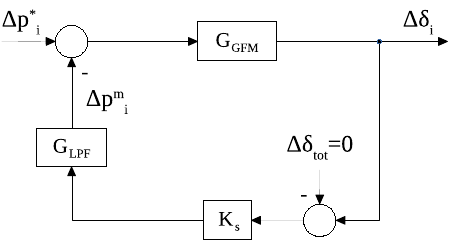
Figure 6. Small-signal block diagram for the study of a single oscillator